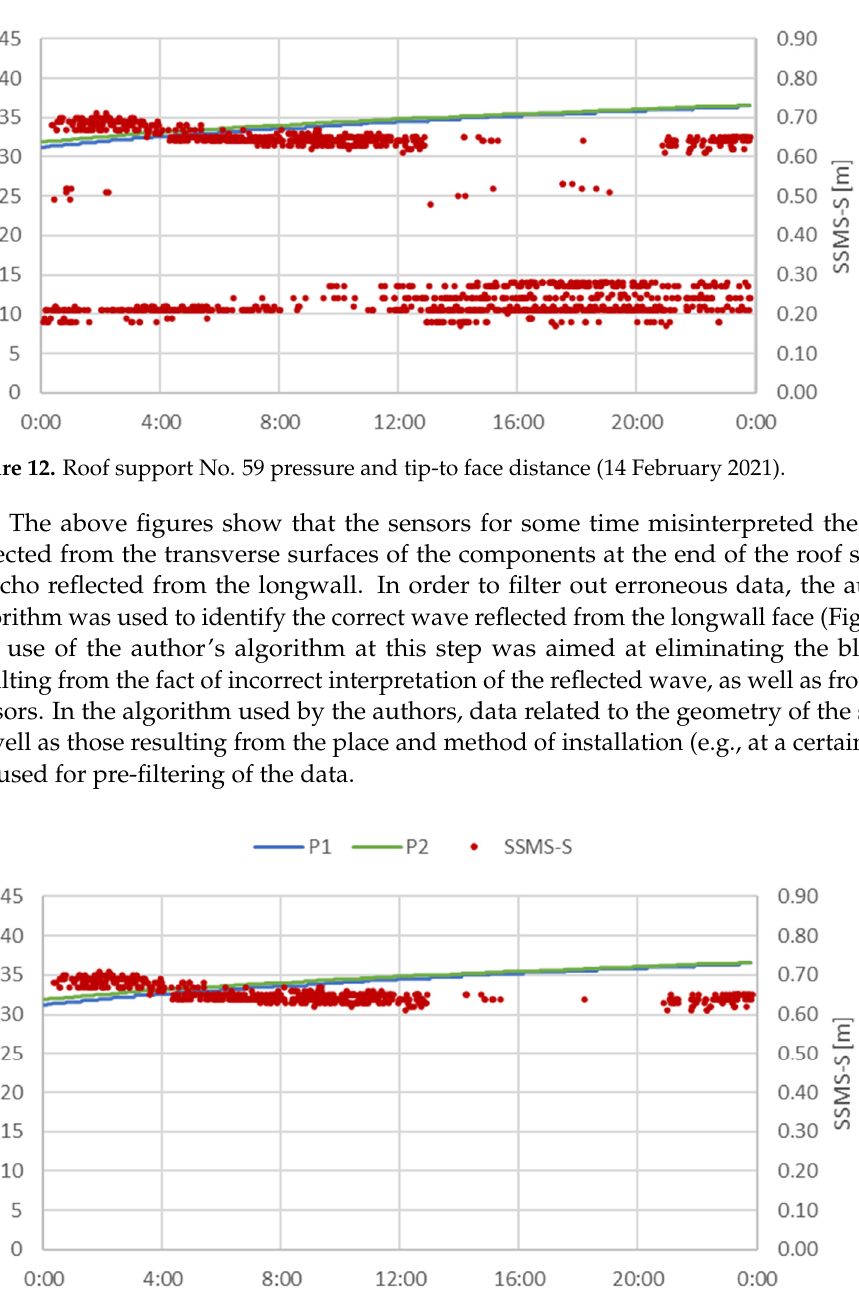
Figure 13. Shield support No. 59 pressure and tip-to face distance (filtered data) (14 February 2021).